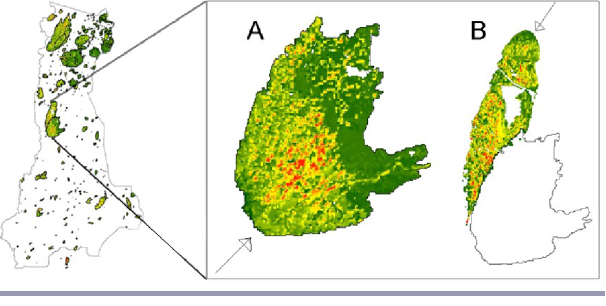
Fig. 5 . Example of fire feedbacks in the study area in which a simulated fire (A) in simulation year 25 limited the growth of a subsequent fire in year 28 (B). Pixels represent flame length from a low of 1 (green) to high of 54 m (red). Arrows indicate direction of fire spread. Fire in A was 14,657 ha and simulated at ERC = 80 and wind speed = 18 mph. Fire in B was 8609 ha at ERC = 81 and wind speed = 16 mph. Fire B without A burned 12,286 ha.